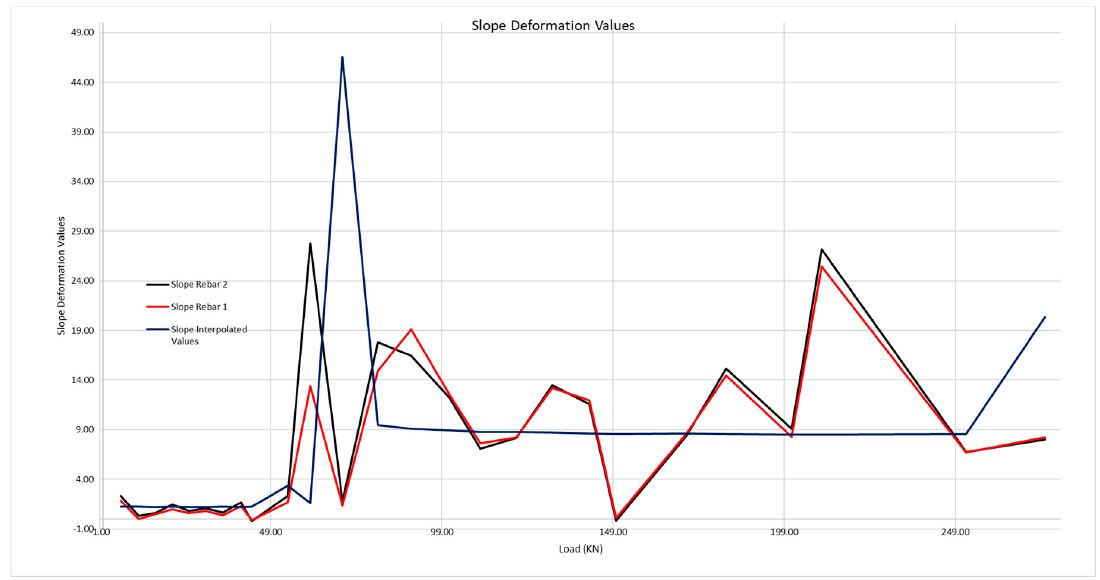
Figure 26. Slope theoretical deformation curves of the rebars (interpolated values) and of rebars 1 and 2.